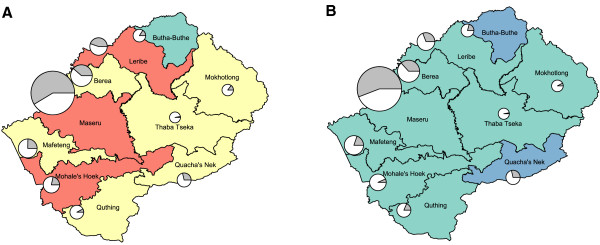
Cartographic maps of HIV prevalence shown for healthcare districts and stratified by gender. HIV prevalence is characterized for each healthcare district for (A) women and (B) men into the following categories: 11 to 16% (blue), 17 to 21% (green), 22 to 26% (yellow), 27 to 31% (red). For each healthcare district, the population in the urban center is indicated by the size of the circle. Within each circle, the gray region represents the proportion of HIV-positive individuals who live in the urban center, and the white represents the proportion that live in rural areas.